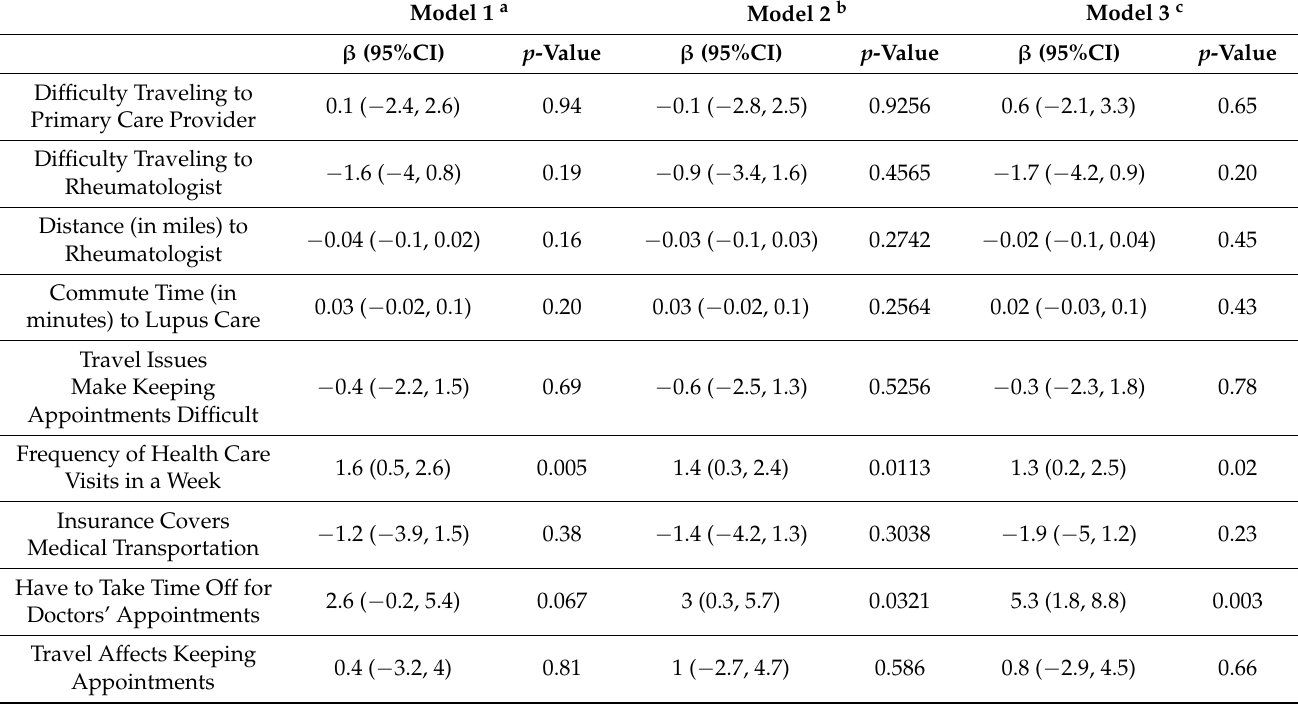
Table 3. Linear Regression Model of the Effect of Travel Burden Indicators on Depression